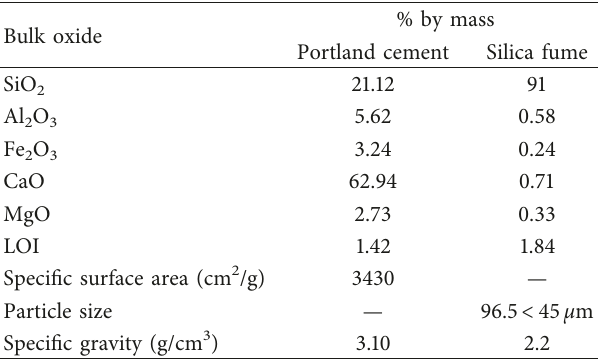
Table 1: The chemical properties of cement and silica fume. Bulk